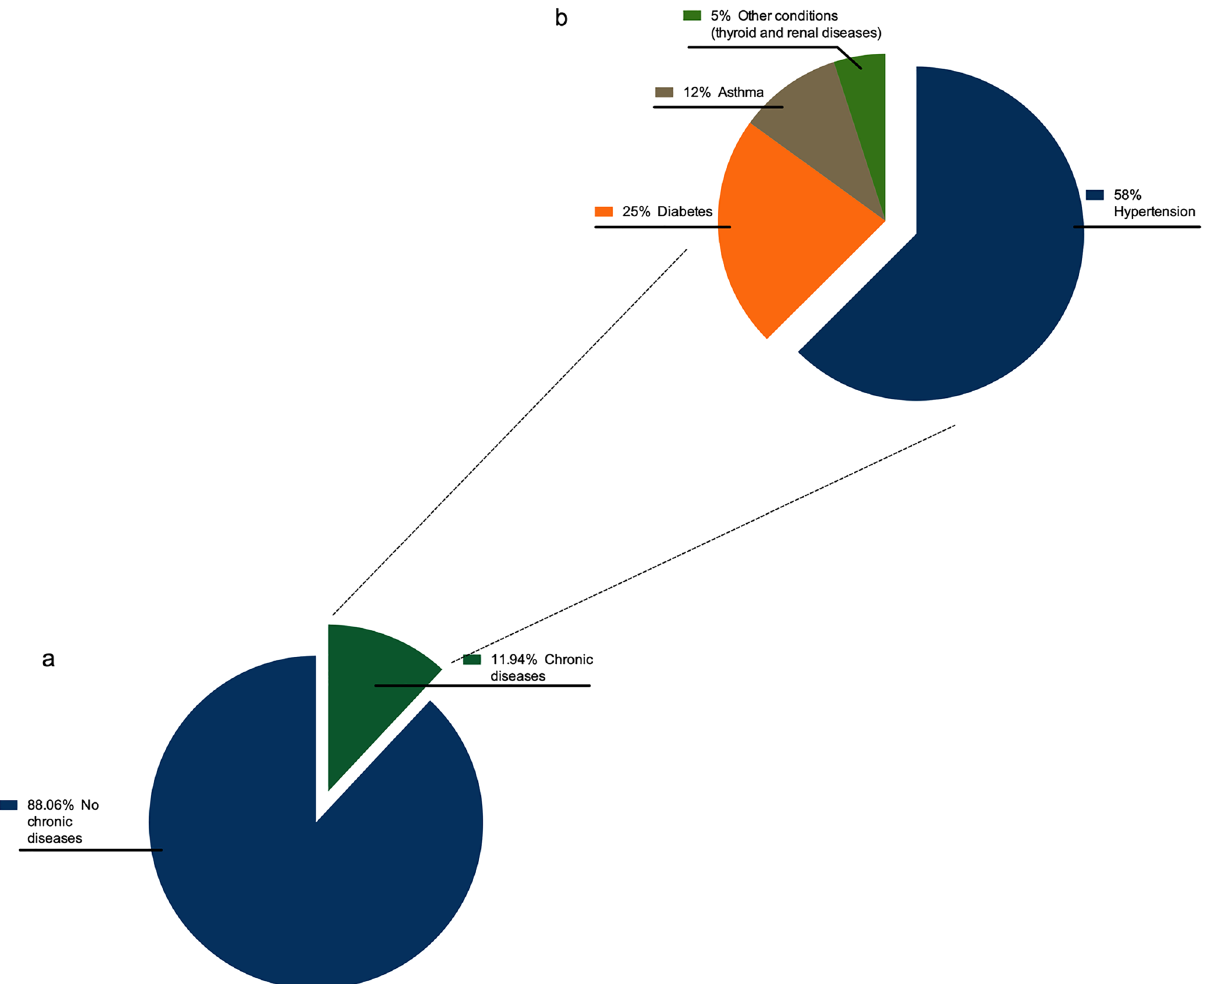
Figure 2. Chronic diseases among SARS-CoV-2 positive subjects. ( a ) 12% of SARS-CoV-2 infected subjects, had chronic diseases. ( b ) Hypertension represented 58% of recorded chronic diseases, followed respectively by diabetes (25%) and asthma (12%). Other conditions (including thyroid and renal diseases) represented 5% of recorded chronic disease Time to SARS‑CoV‑2 negativity.